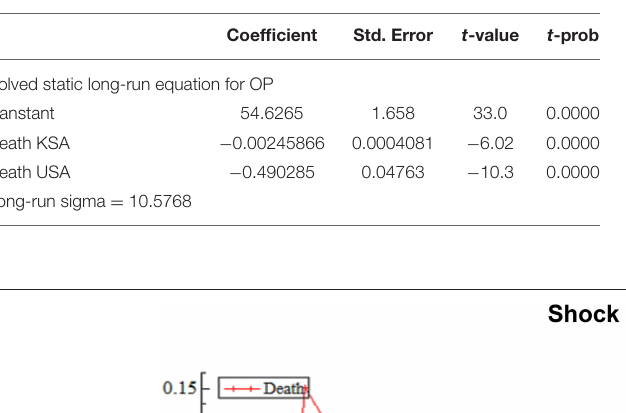
TABLE 3 | The long-term effects.